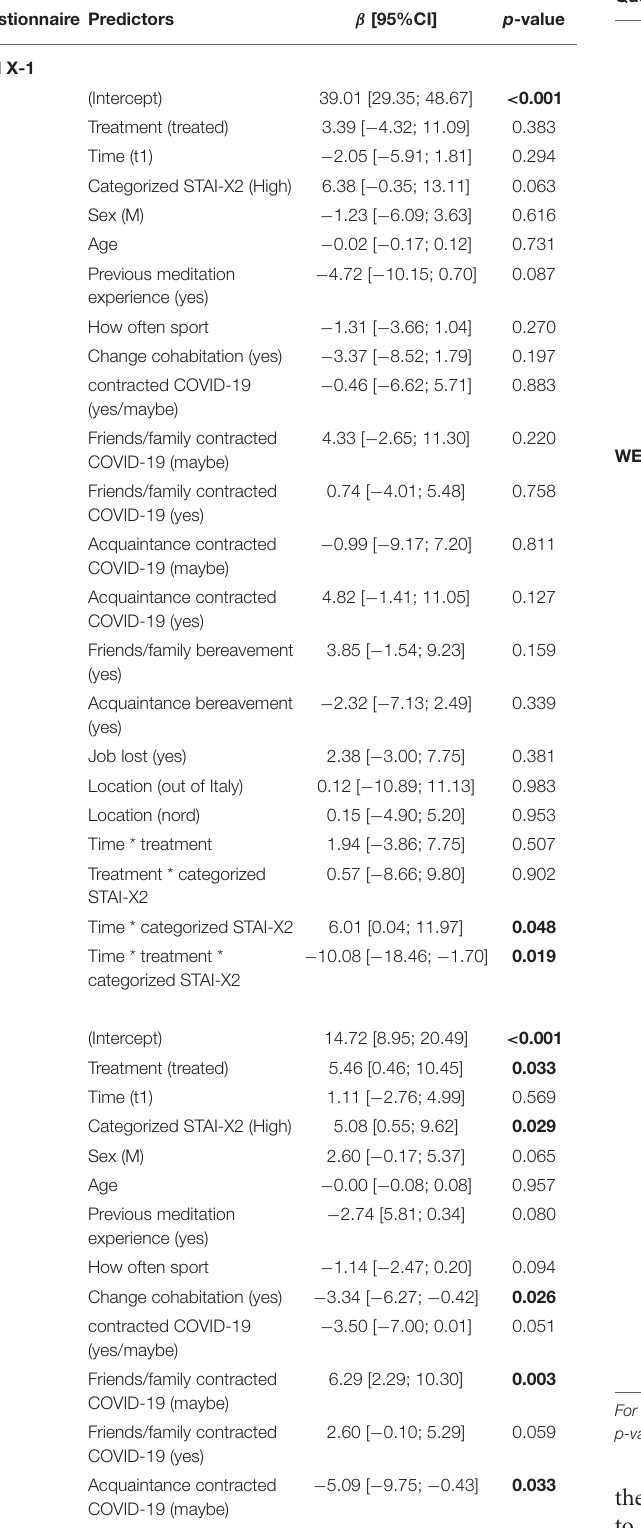
TABLE 3 | Results of the linear mixed models for the effect of treatment and categorized STAI-X2 on the investigated outcomes. Questionnaire